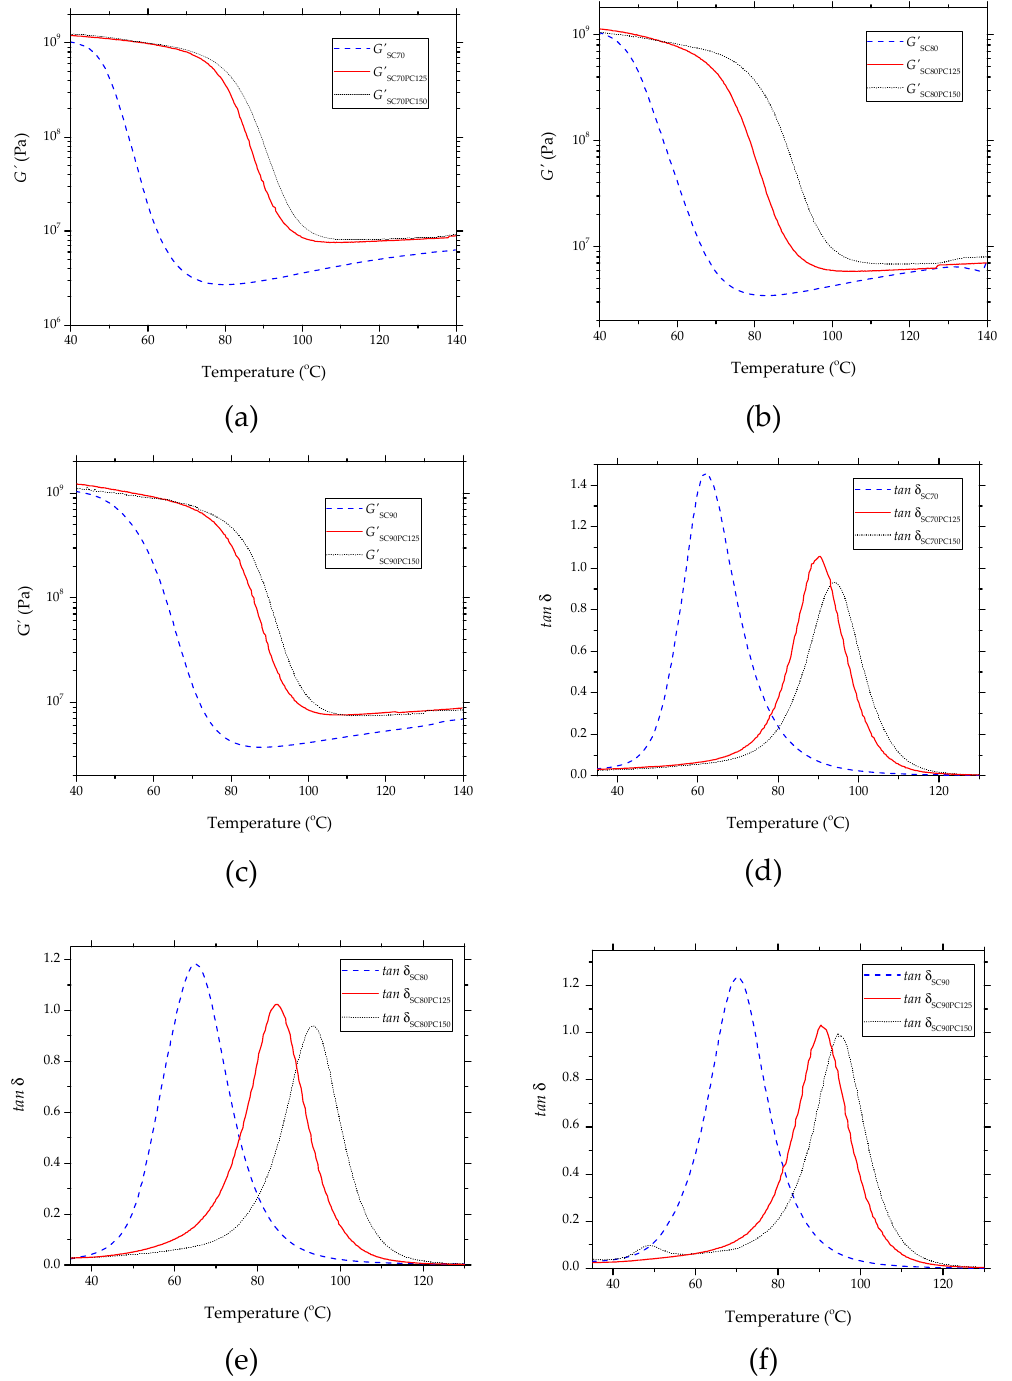
Figure 5. Thermomechanical behavior of the partially bio-based epoxy resins subjected to standard curing (SC) and post-curing (PC) treatments: ( a,b,c ) storage modulus ( G’ ); ( d,e,f ) damping factor ( tan δ ). Table 5. Storage modulus ( G’ ) at 40 ℃ and 110 ℃ and glass transition temperature (T g ) of the